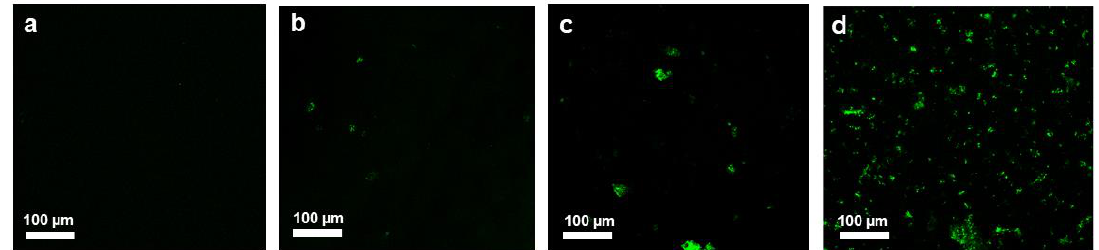
Figure 9. Untreated E. coli without observable fluorescence ( a ), changes of ROS production after treatment of GO ( b ), after treatment with Ag NPs ( c ), and after treatment with GO-Ag NPs ( d ), respectively. The fluorescent images are captured under CLSM after dying with DCFH-DA (green indicator).